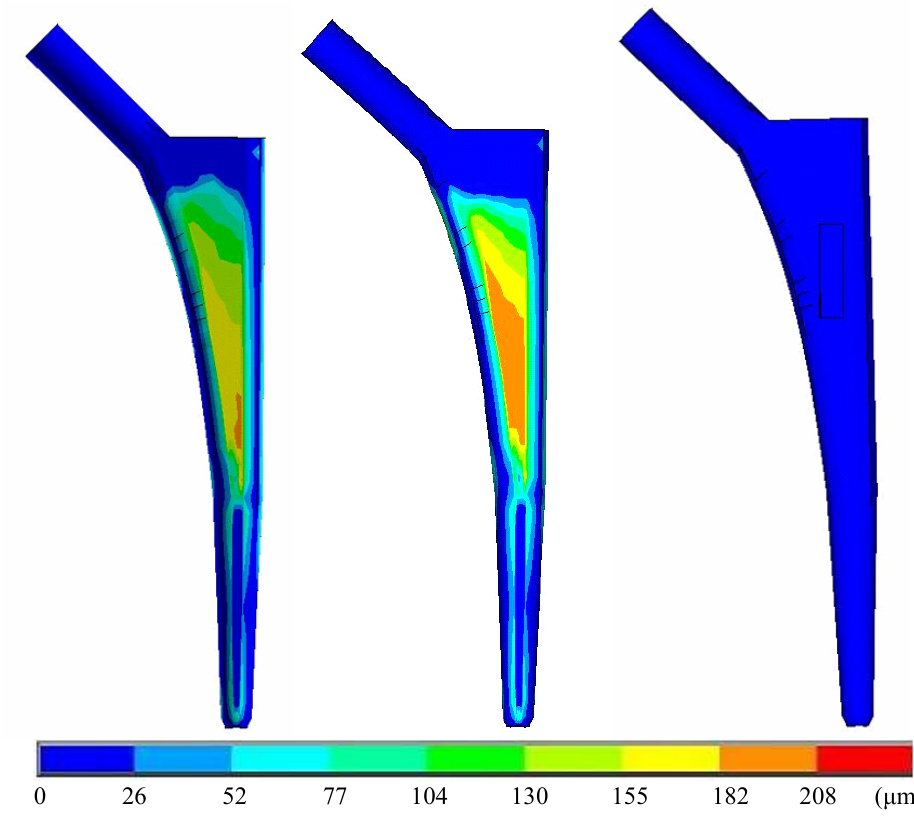
Fig. 3 Anterior view of relative micromotion induced at the bone-implant interfaces by the joint contact force. Each contour plot represents (from left to right) Ti alloy, SMA without shape change and SMA with shape change